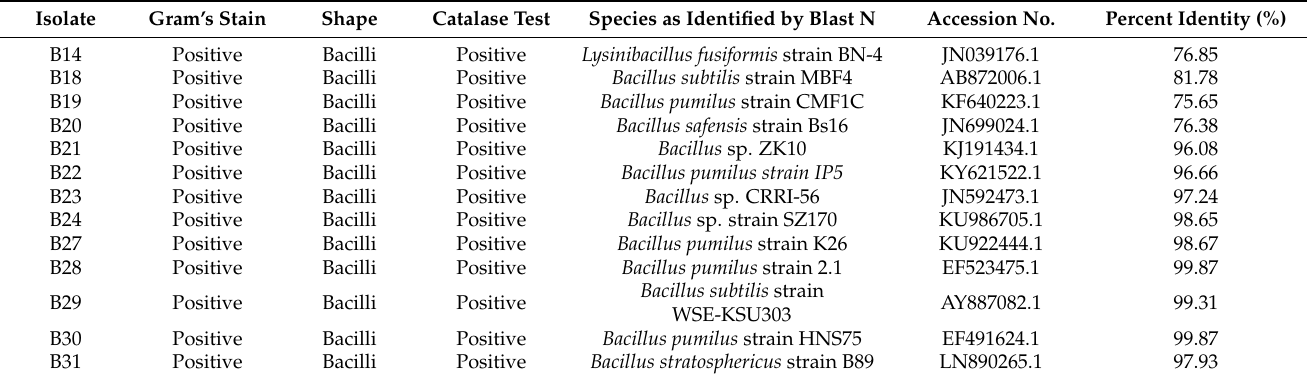
Table 2. Probiotic properties of candidate Bacillus spp. isolated from the intestine of Nile tilapia.